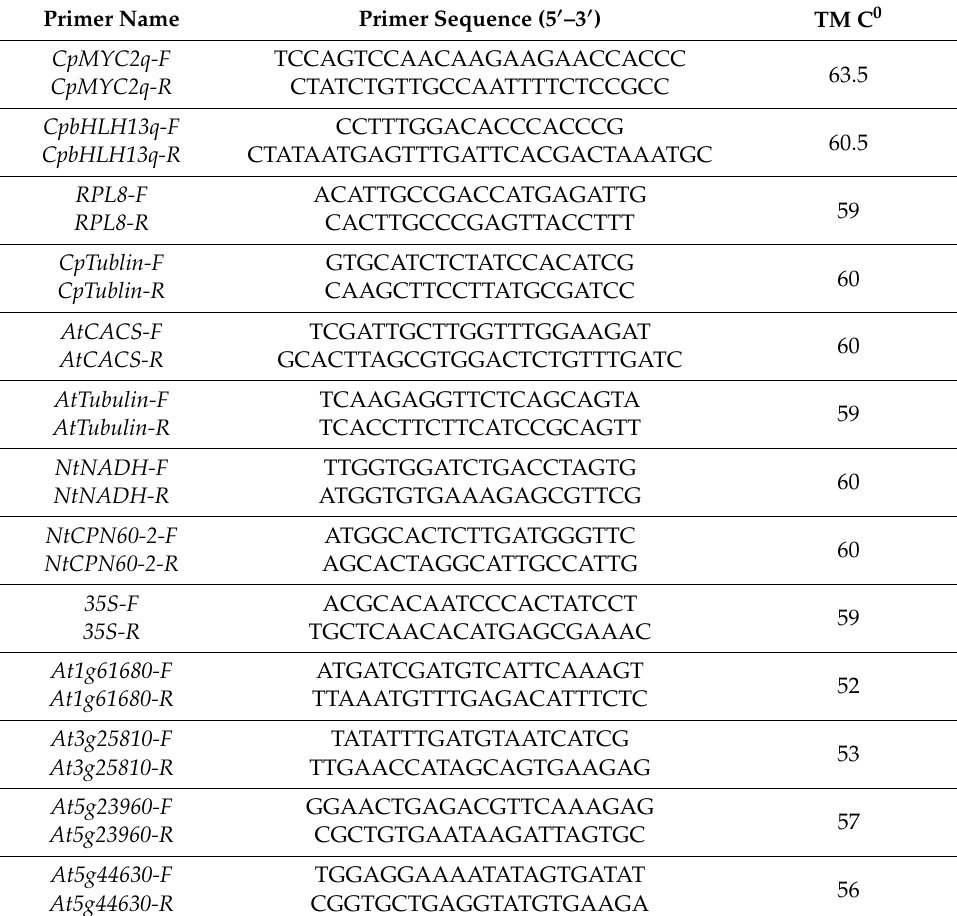
Table 4. Primers for qRT-PCR analysis.